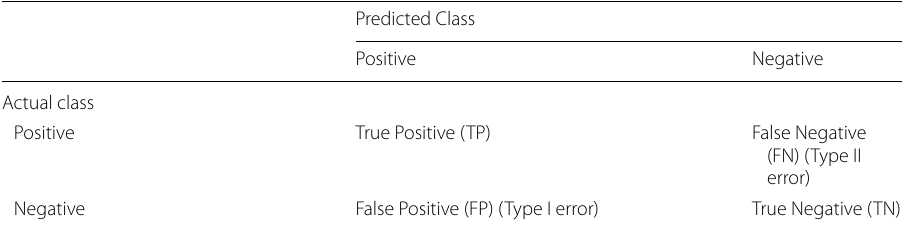
Table 1 Confusion